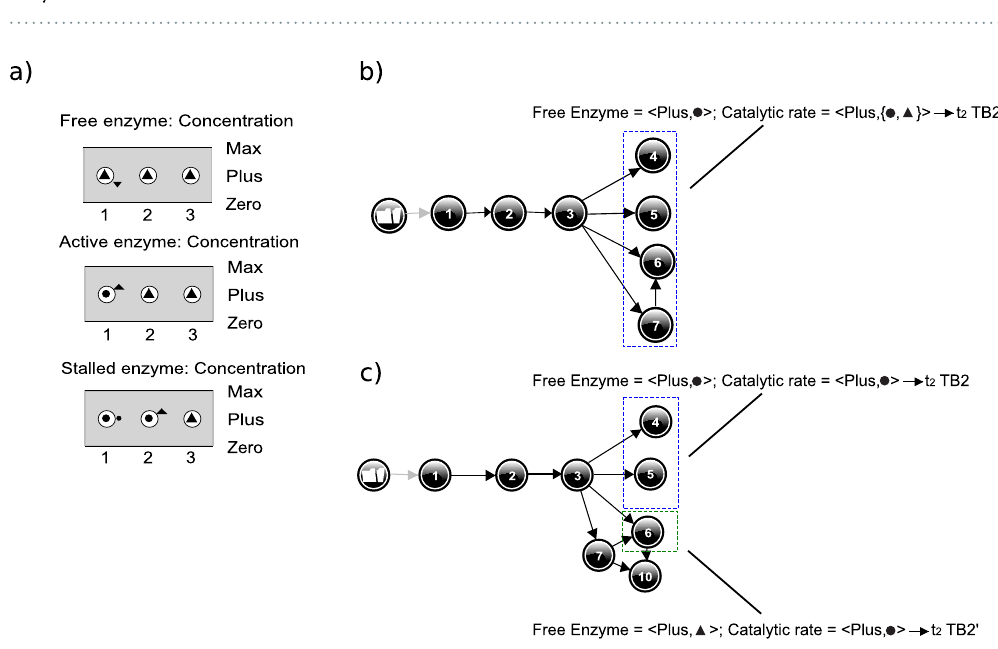
Figure 11. Enzyme evolution in M2 vs simulation data from the source publication. The evolution of the percentage of enzyme in each state for the BP [1 → 2 → 3 → 5 → 6 → 4] in x-axis, is placed on top on actual simulation curves from Cruys-Bagger et al . 20 . Red is Active enzyme, black is Free enzyme and green is Stalled enzyme.